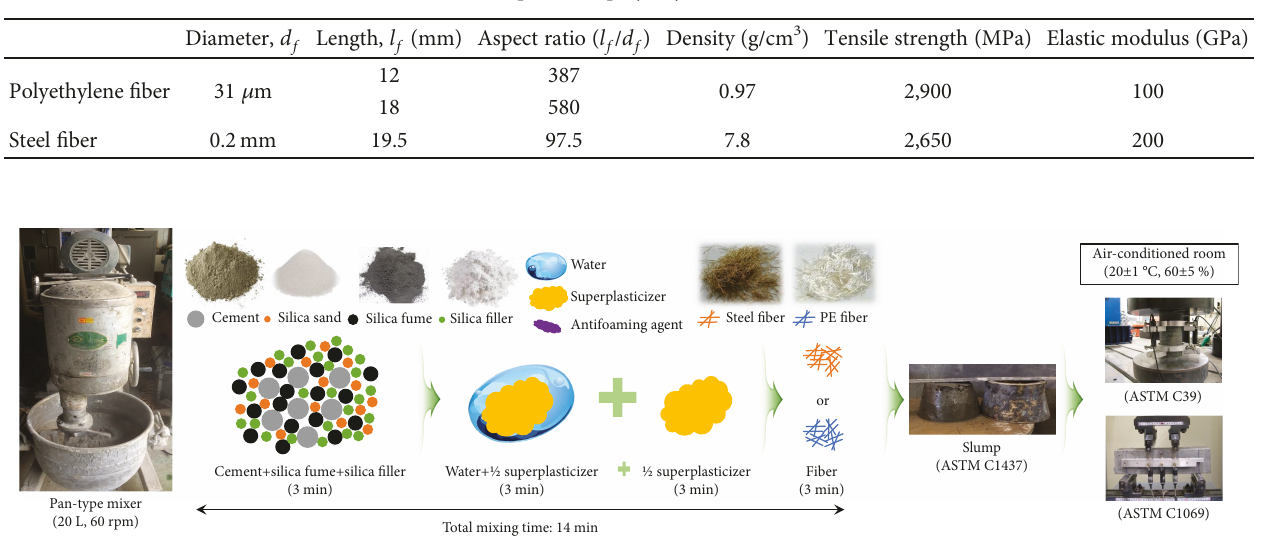
Table 4: Properties of polyethylene and steel fi ber.